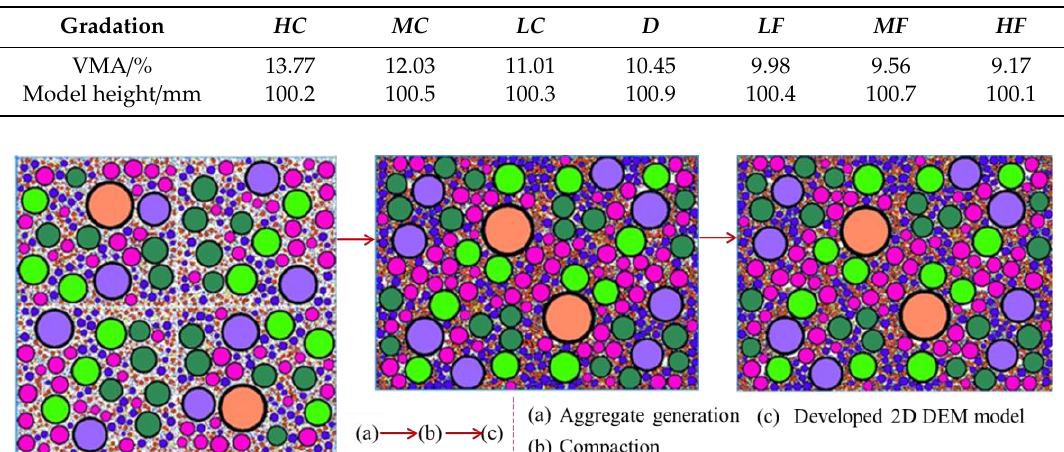
Table 3. VMA of the mixture and height of the model.